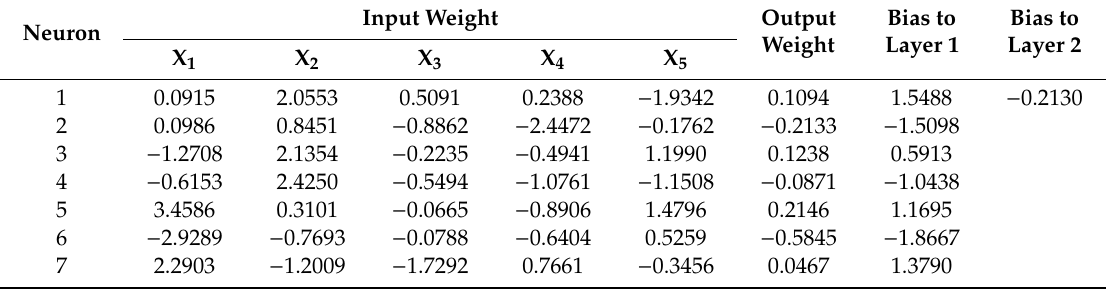
Table 7. The matrix weights between the input and the hidden layer of the ANN